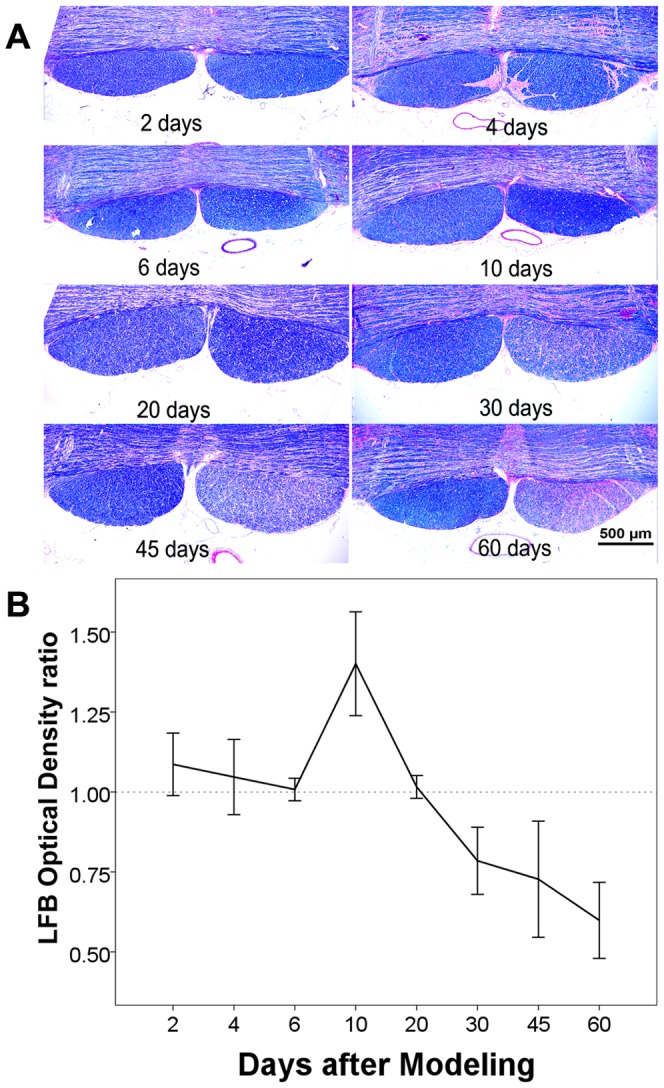
Quantitative analysis of LFB stain.(A) LFB stained histological images of the pons at 2nd, 4th, 6th, 10th, 20th, 30th, 45th and 60th day after modeling. Scale bar, 500 µm. (B) Time course of the LFB optical density ratios between the degenerated and normal sides of CST. Progressive decreases of optical density were shown 20 days after modeling, implying the clearance of myelin debris.